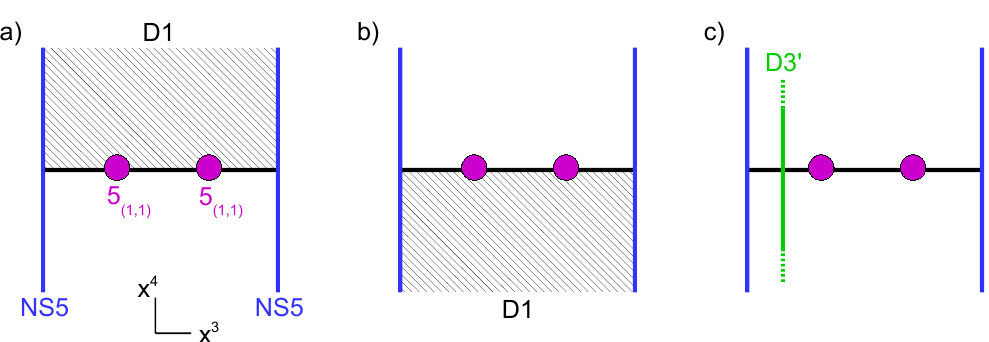
Figure 8 . Brane setups (in the x 3 ; 4 plane) inserting: (a) v + , (b) v (cid:0) , (c) ’ 1 (cid:17) X